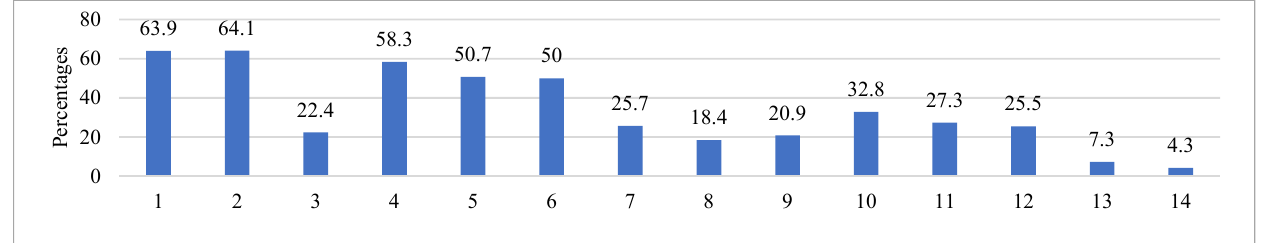
Figure 3. Attitudes towards advertising ( n = 396; %). 1 Advertising provides information about the goods/services offered; 2 Advertising provides information about new goods/services; 3 Advertising keeps in mind the potential need for the product/service; 4 Advertising increases brand awareness of the product/service; 5 Advertising increases sales of the product/service; 6 Advertising encourages consumers to choose/buy the advertised product/service; 7 Advertising shapes your attitudes as a consumer towards product/service features and consumption; 8 Advertising influences the development of sustainable mobility and multimodality in cities; 9 Advertising provides information on the importance of sustainable mobility and multimodality; 10 Advertising provides information on innovative/alternative ways of travelling in cities; 11 Advertising encourages passengers to choose innovative/alternative ways of travelling in cities; 12 Advertising shapes passenger attitudes towards innovative/alternative travel modes; 13 Advertising has no benefit; 14 Advertising is not